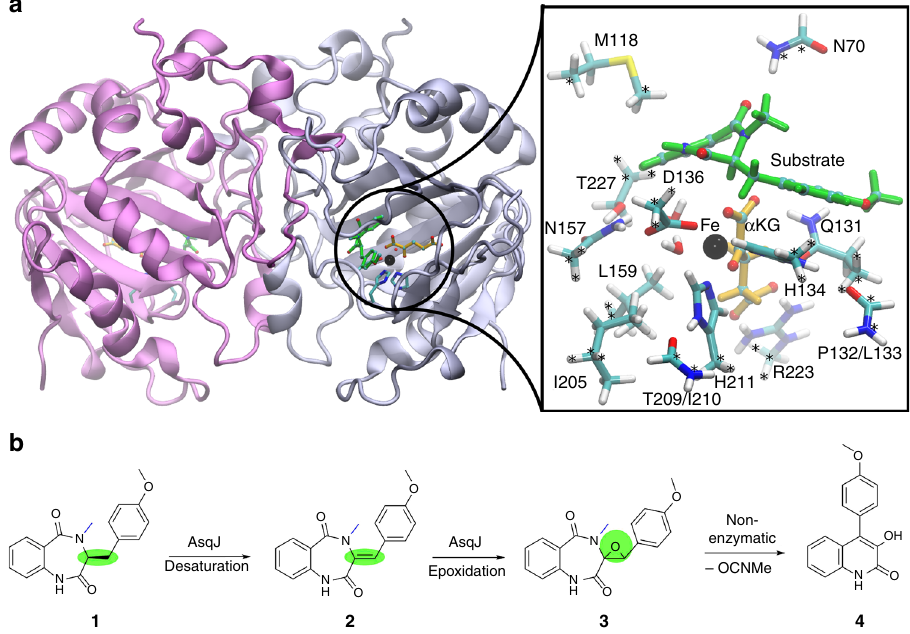
Fig. 1 The structure and active site of AsqJ. a The dimeric protein structure of AsqJ (PDB ID:5DAQ; one subunit in the asymmetric unit), depicting the location of the active site. The inset shows a DFT model of the active site of AsqJ, comprising 194 atoms. Atoms marked with asterisk are kept fi xed in the structure optimizations. b Reaction sequence catalyzed by AsqJ. Substrate 1 is the AsqK-produced NRPS product of anthranilic acid and Tyr(OMe); the N4- methyl group is derived from S-adenosylmethionine